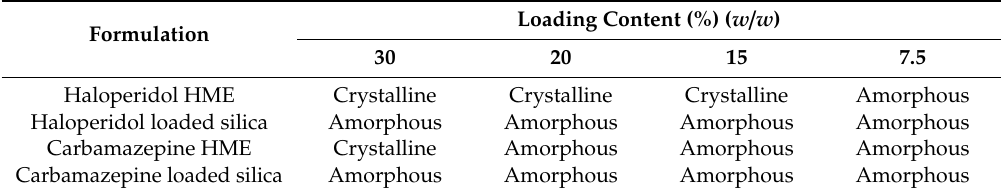
Table 2. Loading Capacities for Both Formulation Techniques.